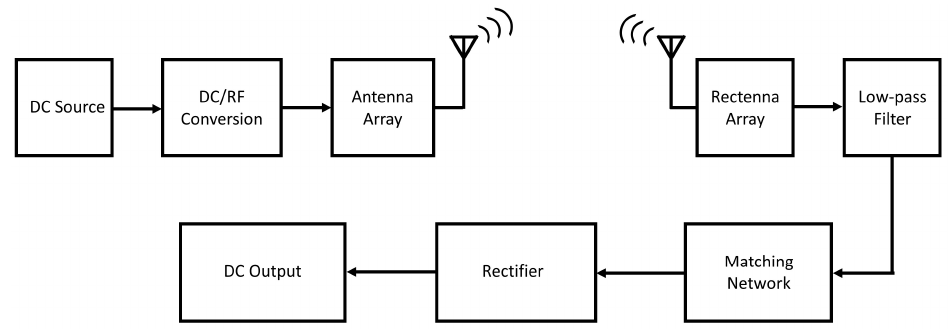
Figure 10. Diagram of WPT based on microwave technology [16].